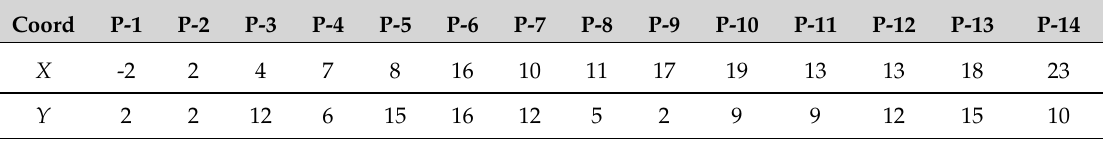
Table 1. 2D coordinates of turn points in Figure 8a